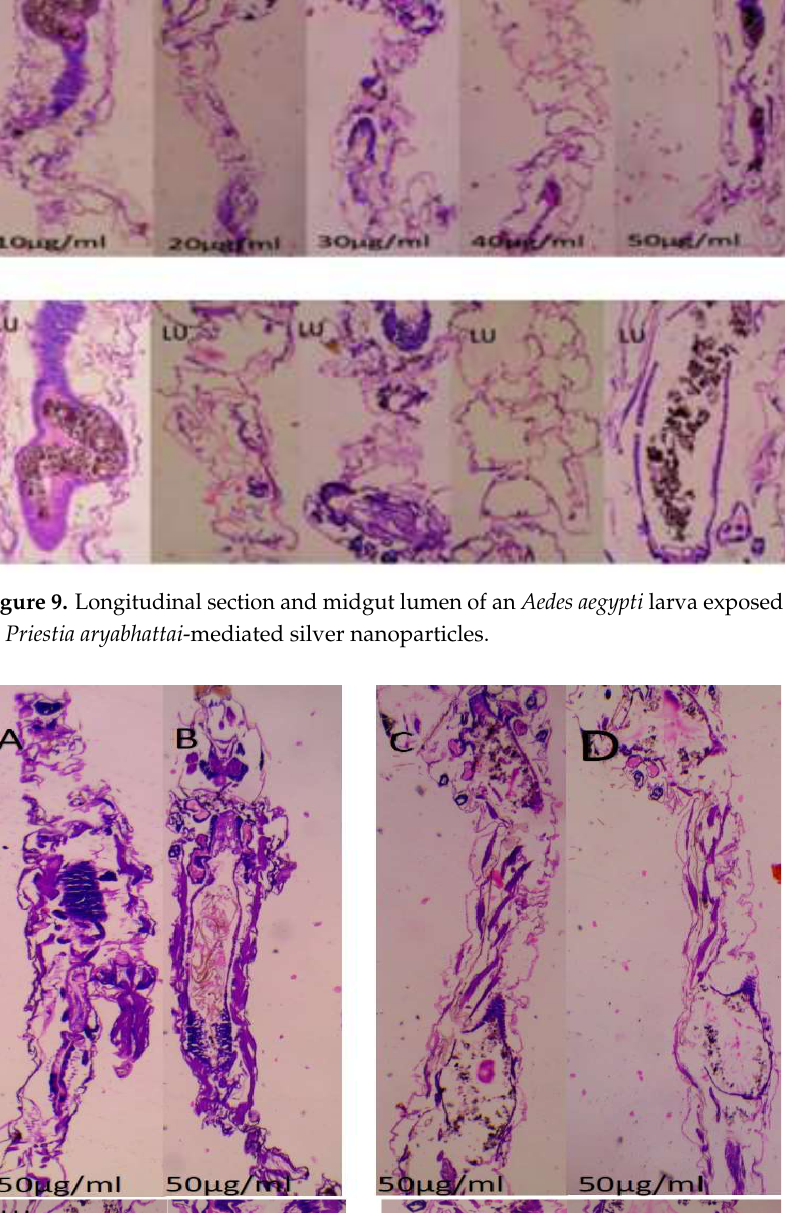
concentrations of Pantoea stewartii -mediated silver nanoparticles.